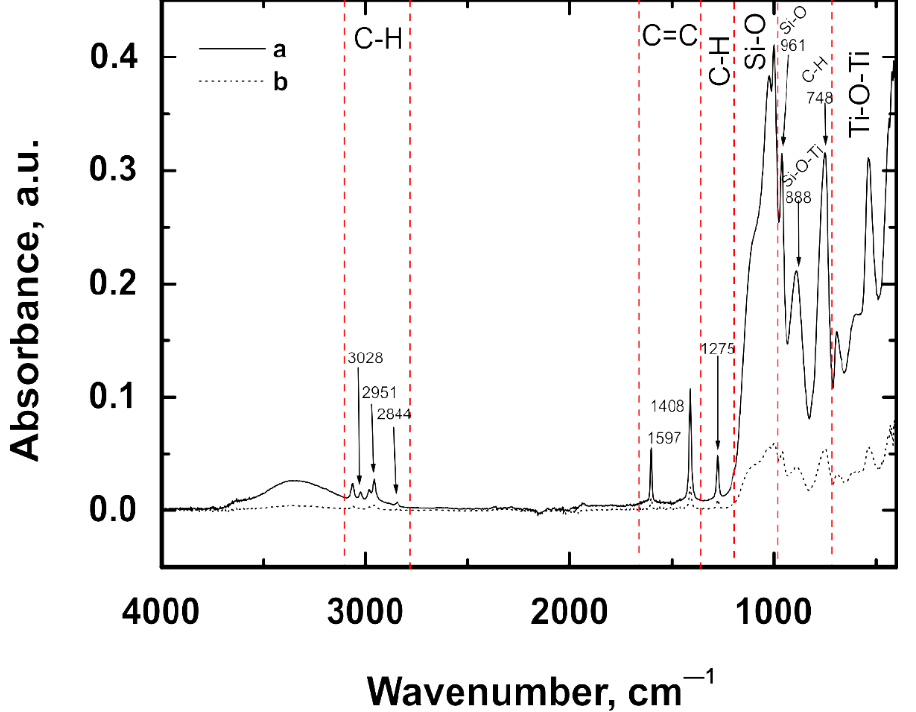
Figure 5. FTIR spectra obtained for VTMS coatings deposited on the Ti Gr 2 (a) and Ti13Nb13Zr (b) substrates.